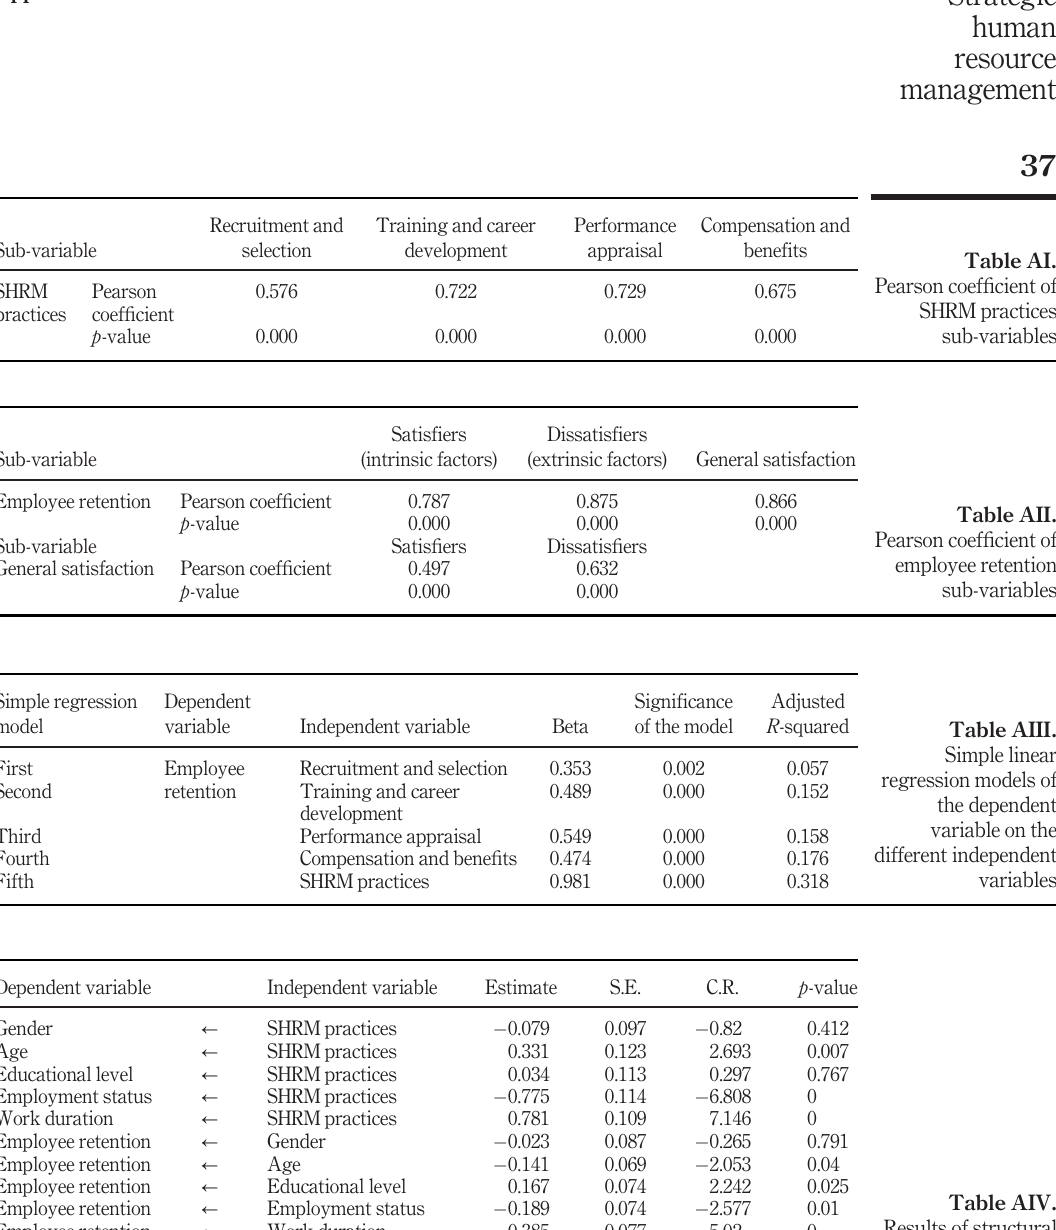
Table AIV. Results of structural equations model